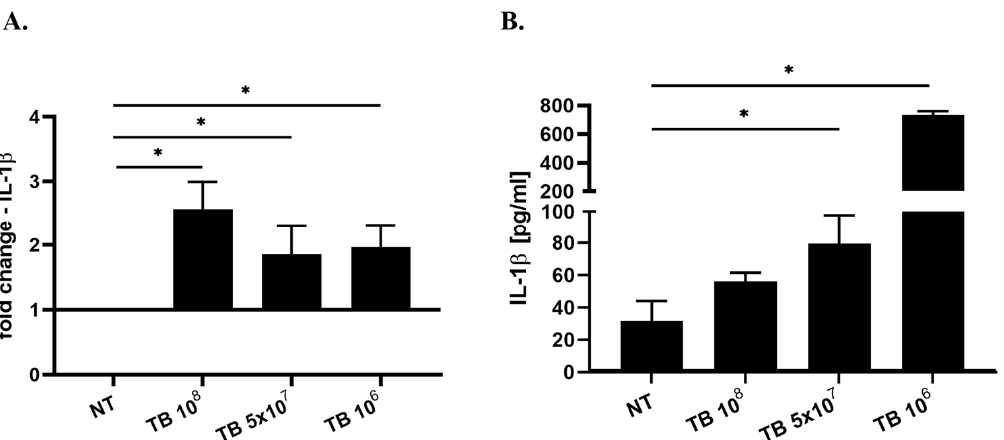
Figure 4. Effect of TB on the gene expression and release of IL-1 β by THP-1-derived macrophages. THP-1-derived macrophages were incubated for 4 h with different concentrations of TB and the effect on the gene expression and protein release of IL-1 β was assessed by Real Time PCR ( A ) and ELISA ( B ), respectively. Data are expressed as mean ± SD (N = 4). For statistical analysis, repeated measures ANOVA with Bonferroni post hoc test was applied. * p < 0.05 vs. NT.